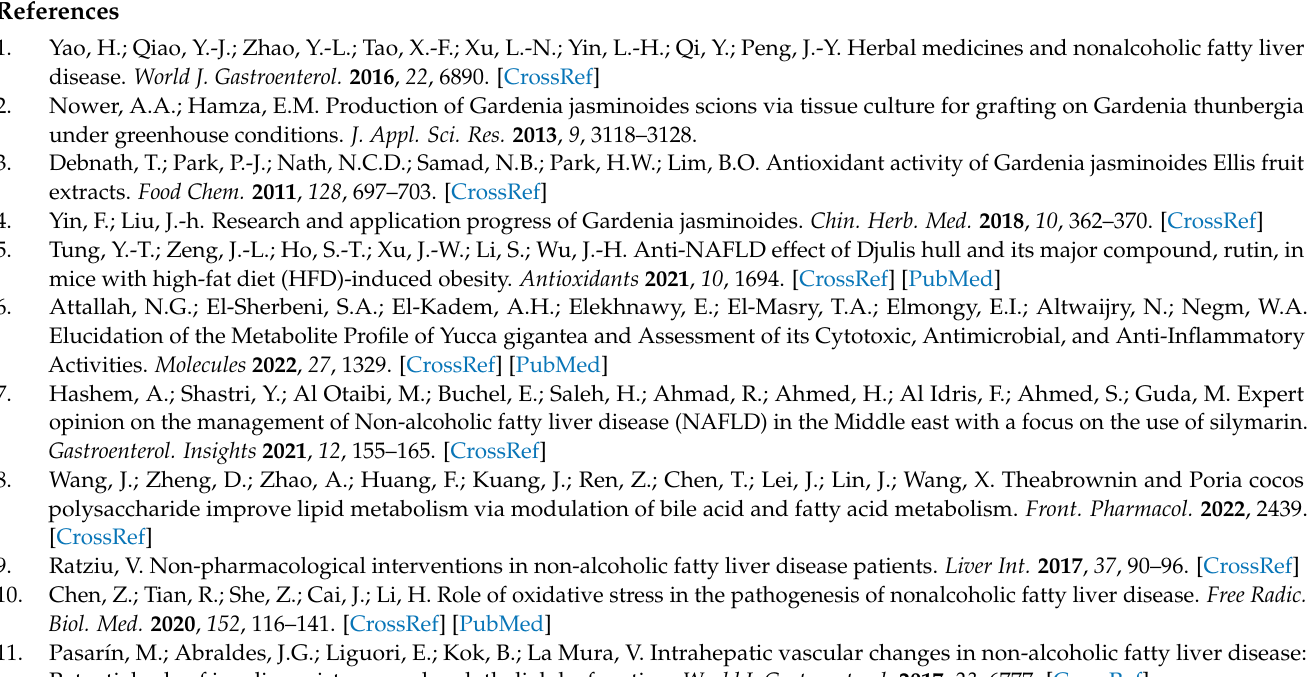
ter (USM) of G. thunbergia methanol extract of leaves; Figure S5: EI-MS spectrum of fucosterol; Figure S6: 1 H-NMR spectrum of fucosterol (CDCl 3 , 400 MHz) ; Figure S7: APT spectrum of fucosterol (CDCl 3 , 100 MHz); Figure S8: EI-MS spectrum of stigmasterol; Figure S9: 1 H-NMR spectrum of stigmasterol (CDCl 3 , 500 MHz); Figure S10: 13 C-NMR spectrum of stigmasterol (CDCl 3 , 125 MHz); Figure S11: EI-MS spectrum of ursolic acid; Figure S12: 1 H-NMR spectrum of ursolic acid (DMSO, 500 MHz); Figure S13: 13 C-NMR spectrum of ursolic acid (DMSO, 125 MHz); Figure S14: Investigation of G. thunbergia methanol extract of leaves n-Butanol fraction; Figure S15: ESI-MS (negative mode) spectrum of rutin; Figure S16: 1 H-NMR spectrum of rutin (DMSO, 400 MHz); Figure S17: 13 C-NMR spectrum of rutin (DMSO, 100 MHz); Figure S18: HMBC spectrum of rutin